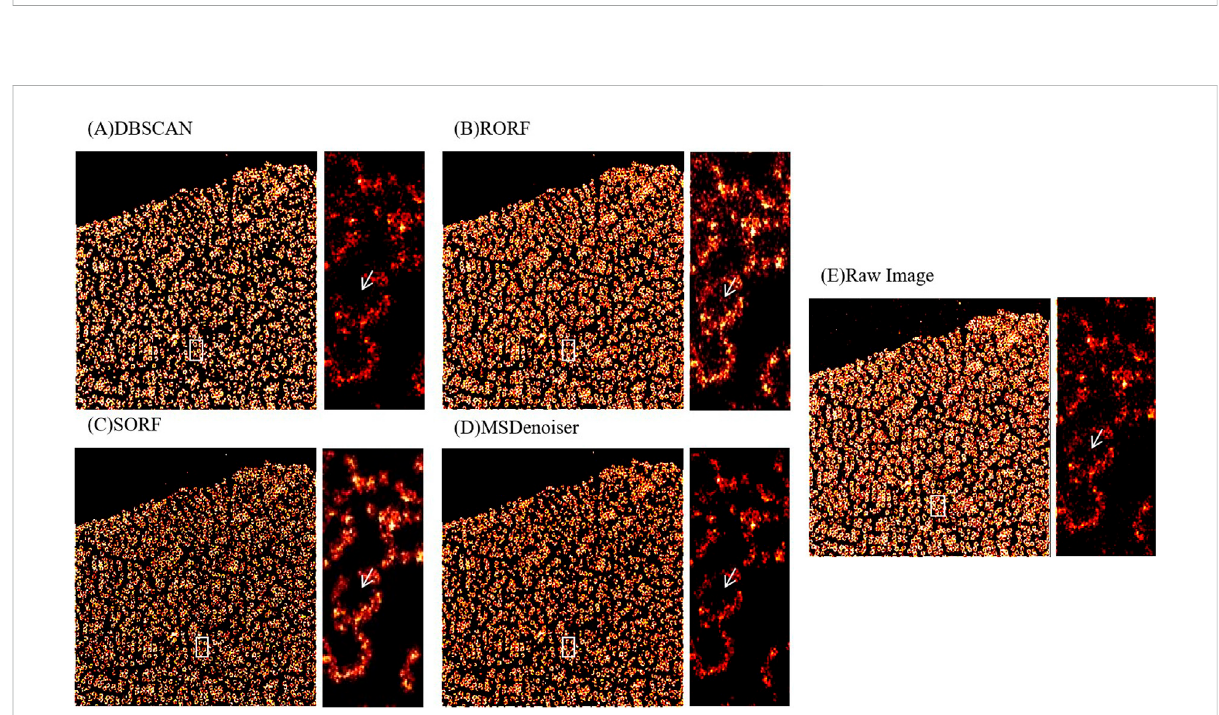
FIGURE 7 Comparison on the denoising performance of different methods using experimental nuclear pore complexes data. (A) Denoised image from DBSCAN. (B) DenoisedimagefromRORF. (C) DenoisedimagefromSORF. (D) DenoisedimagefromMSDenoiser. (E) Rawrenderedimage.Thewhite arrows in (A – E) indicate noise in ring structure, the white arrow in (D) indicates the better denoising effect of MSDenoiser at the same